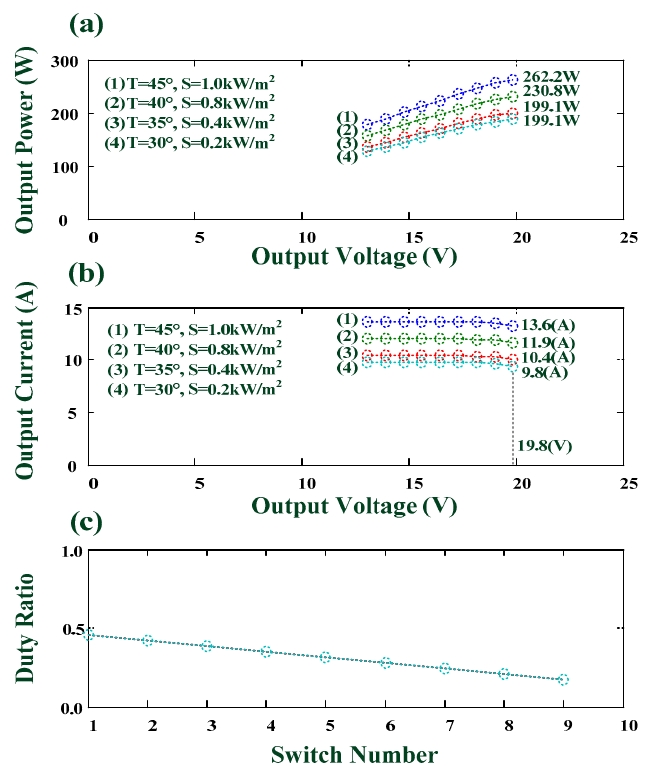
Figure 6. The MPPT estimated results. ( a ) Output power versus output voltage, ( b ) Output current versus output voltage, ( c ) Duty ratio versus switch number.